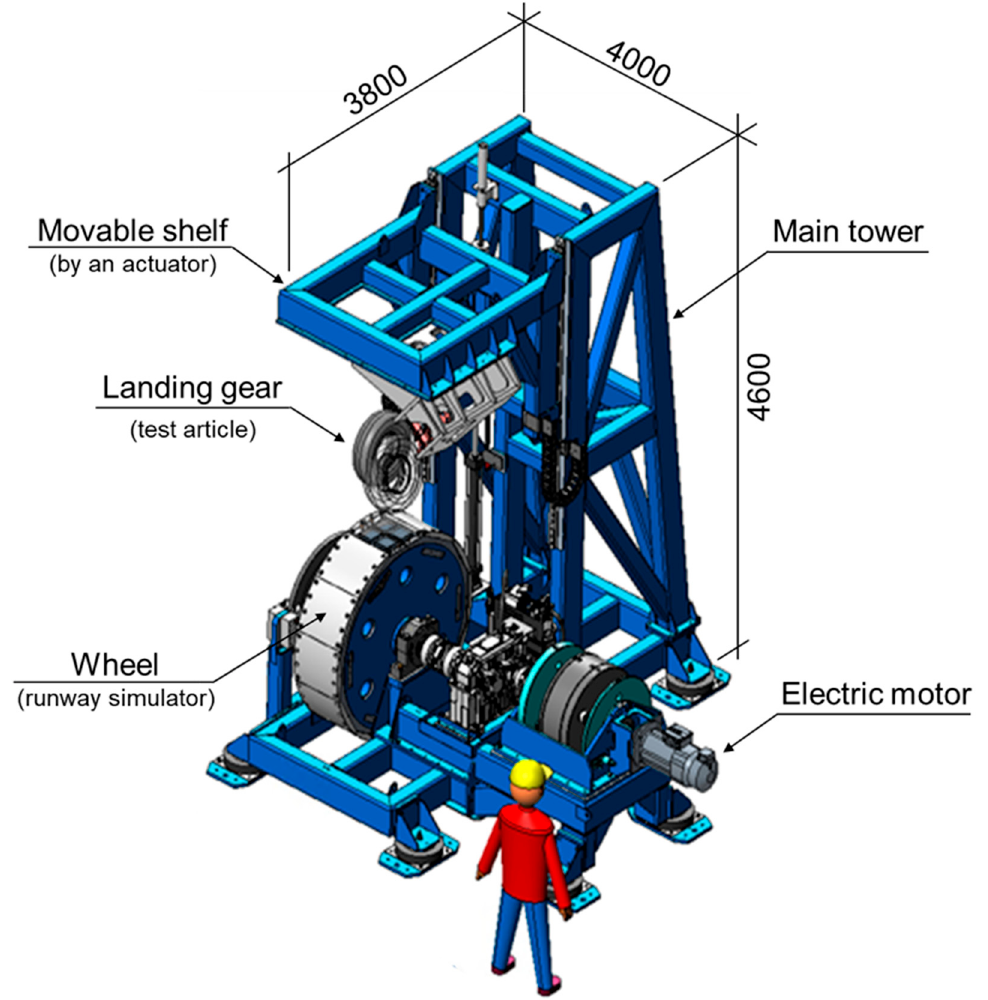
Figure 1. 3D CAD of the landing gear testing machine; units in mm.